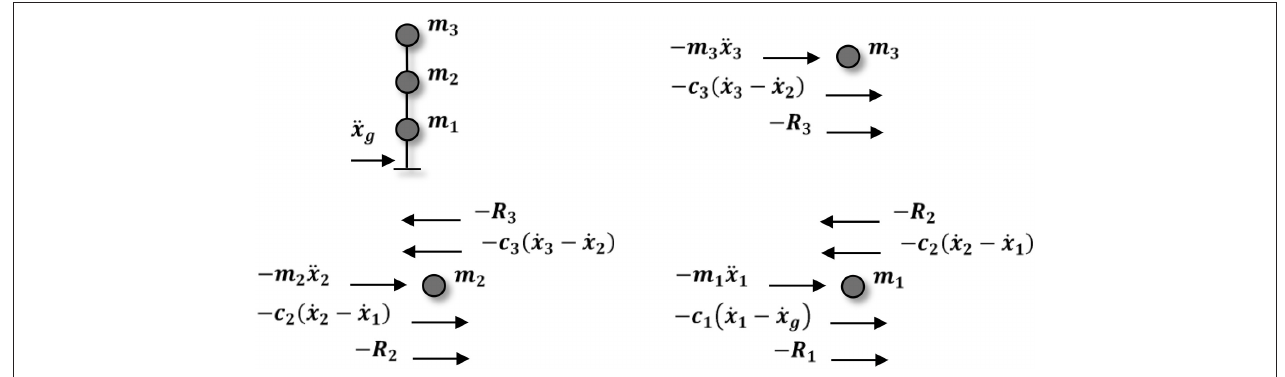
FIGURE 2 | Structural lumped mass